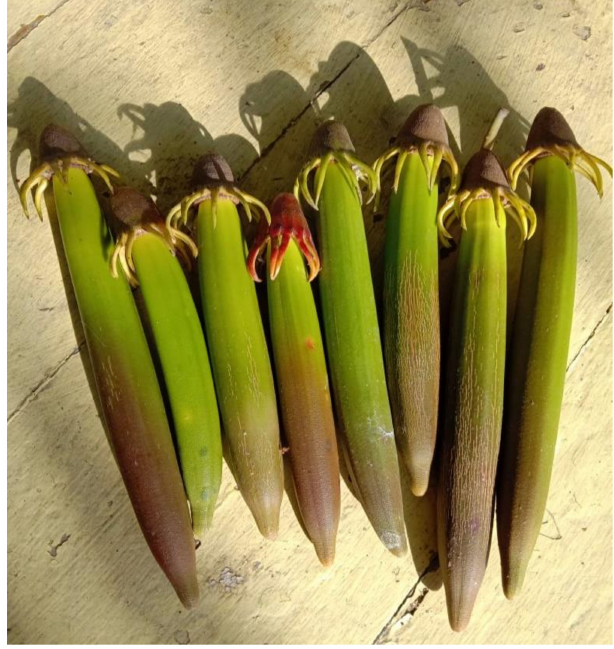
Figure 3. Mangrove/ lindur fruit.